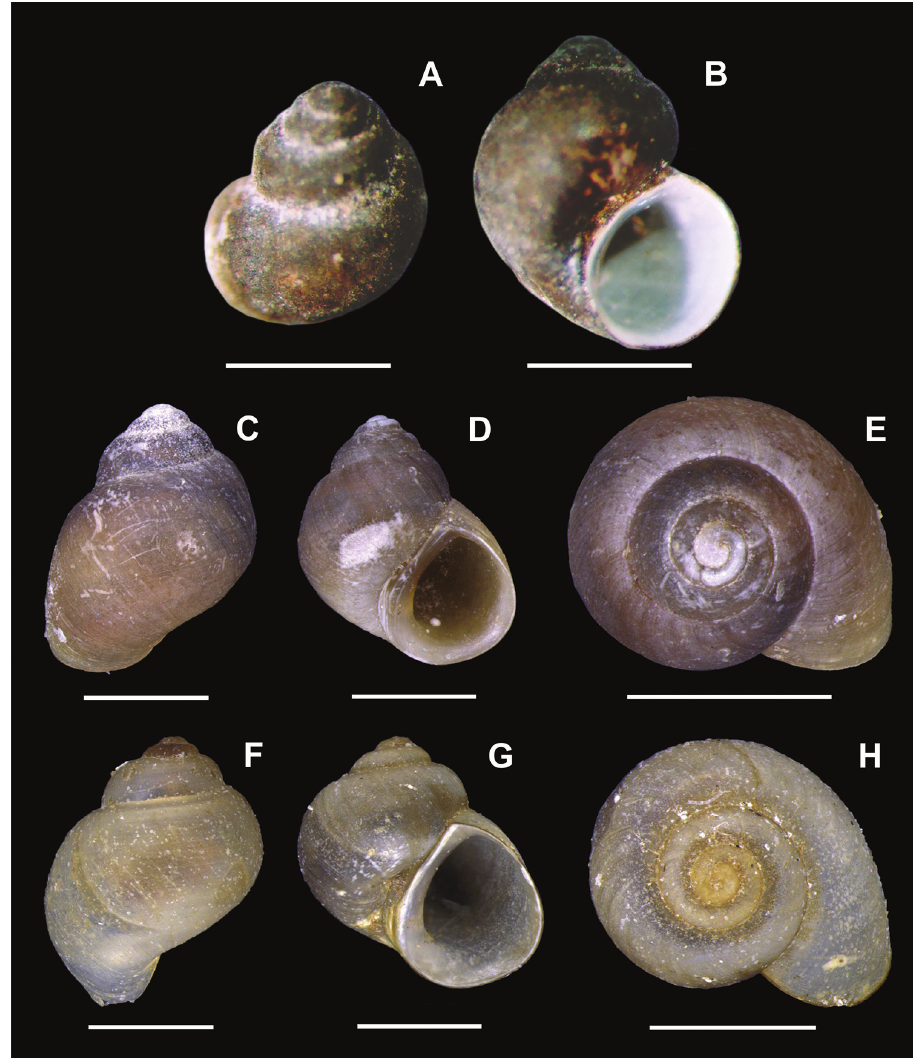
Figure 5. Potamolithus karsticus - A (dorsal view) B (apertural view); Potamolithus sp. 2 C (dorsal view) D (apertural view) E (apical view); Potamolithus sp. 3 F (dorsal view) G (apertural view) H (apical view). Scale bars: 1mm. (Photographs: LBR